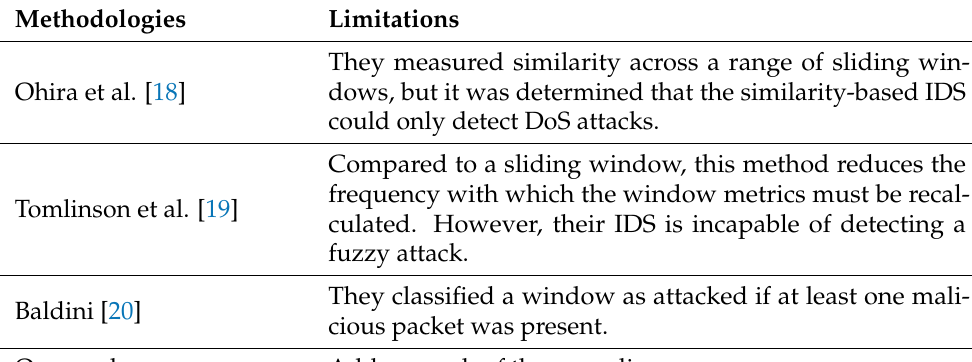
Table 5. Limitations of methodologies using windowing as